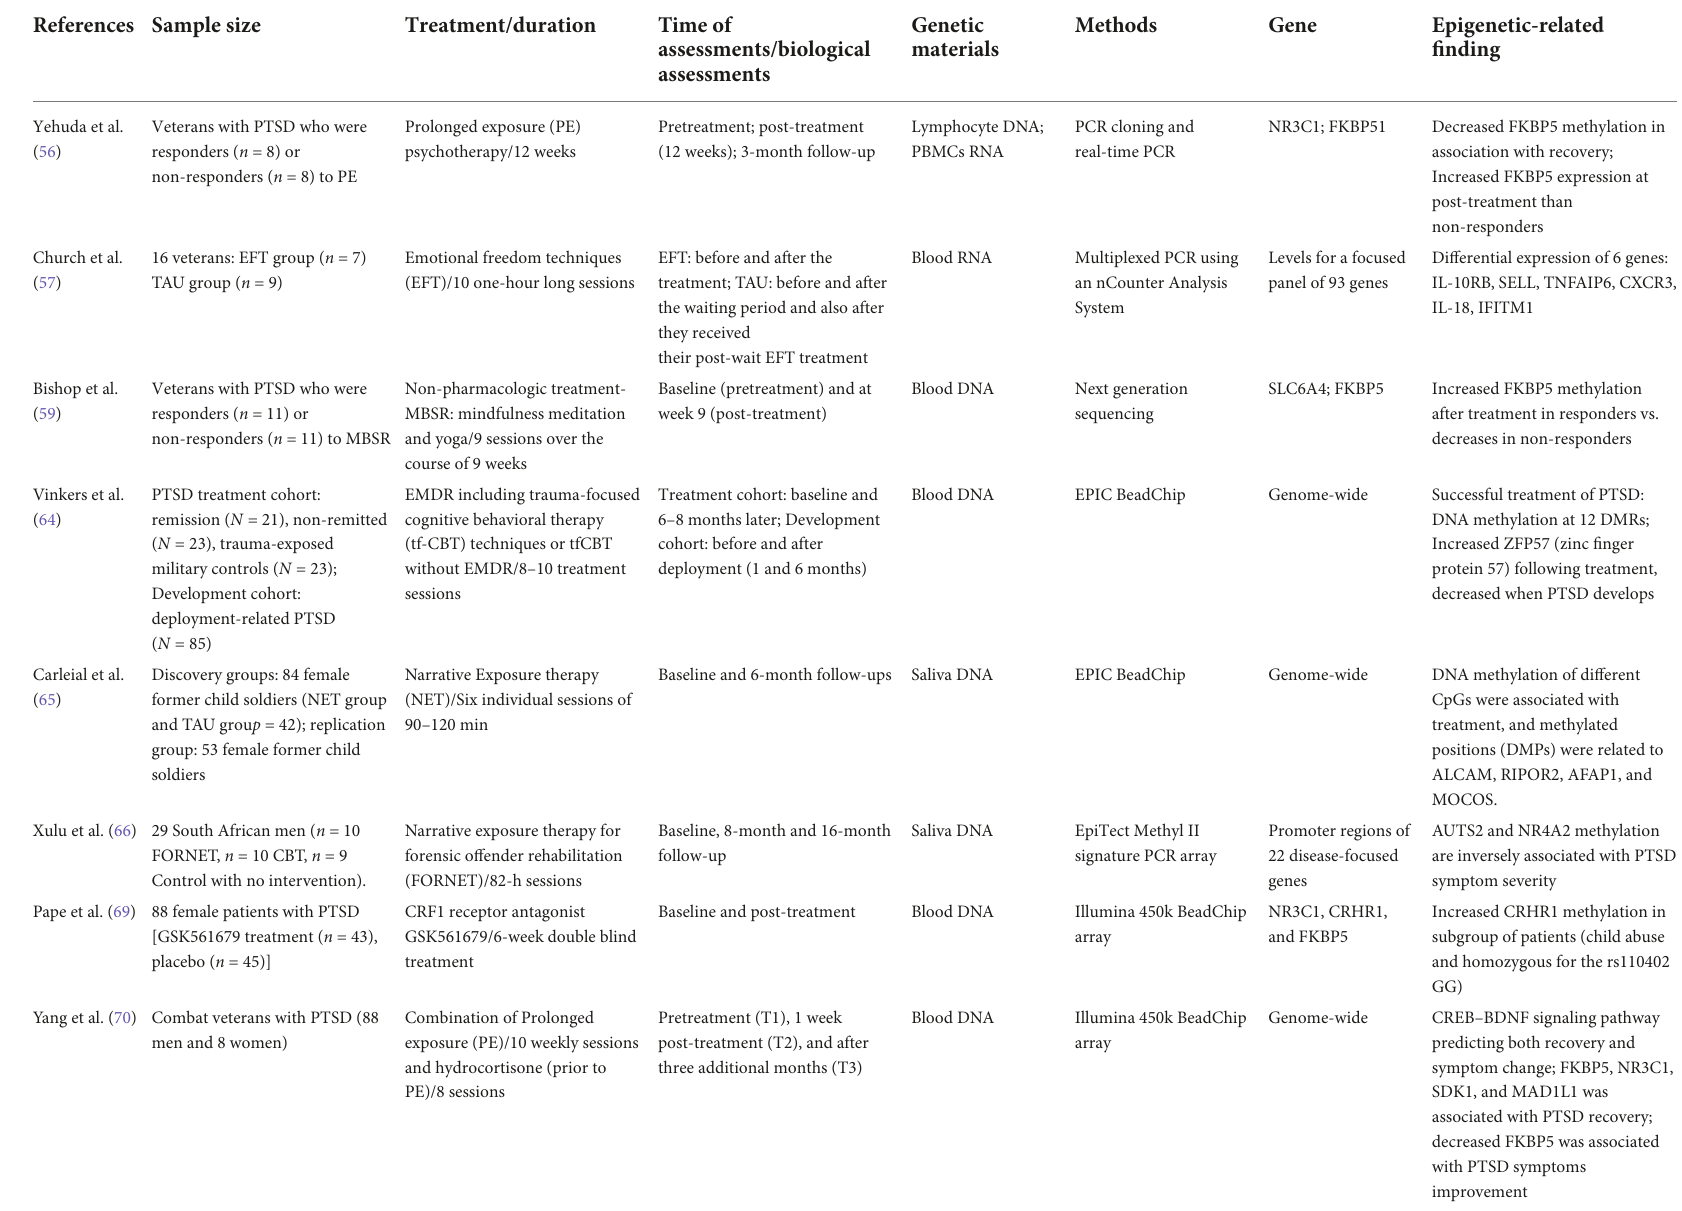
TABLE 1 Epigenetic studies in PTSD